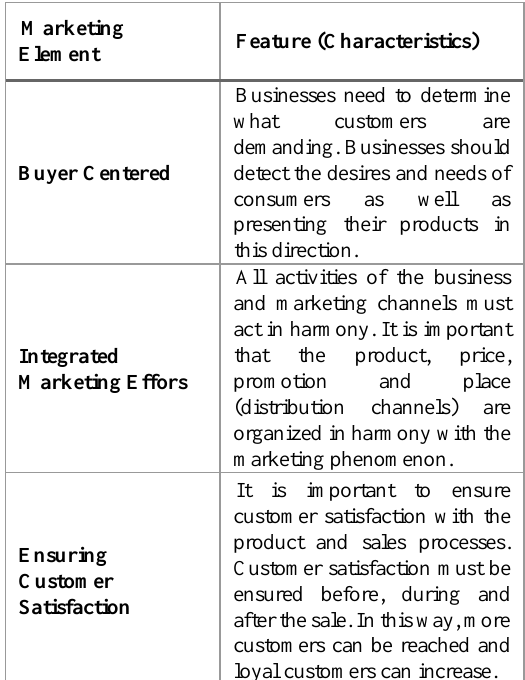
Table 2: Leading Elements of the